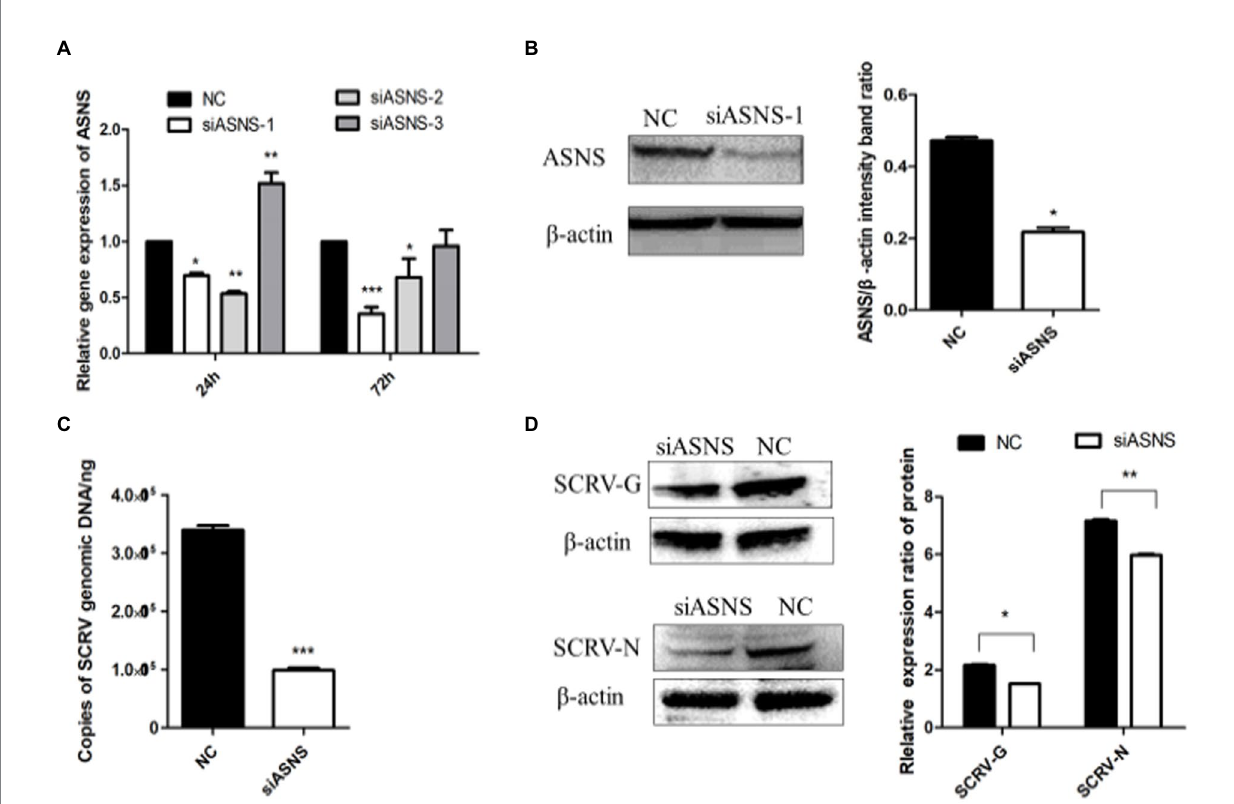
FIGURE 5 ASNS knockdown impaired SCRV replication. (A) The expression of ASNS mRNA in CPB cells treated with si-ASNS was detected. CPB cells fed with glutamine-containing medium were transfected with the three siRNAs and negative control (NC), and the cells were harvested at 24 and 72 h, respectively, and the transcript level of ASNS was detected by qPCR. (B) Validation of siRNA. The protein in the cells was harvested 72 h after siASNS-1 transfection, and western blot was used to verify whether siASNS-1 effectively knocked down the protein expression of ASNS. (C) The yield of SCRV when ASNS is knocked down. The cells were infected with SCRV (MOI = 1.O) 24 h after siASNS-1 transfection. The cells were collected at 72 hpi and the virus production was measured by qPCR. (D) Expression of SCRV-G/N protein in CPB cells after ASNS knockdown. Cells were infected with SCRV (MOI = 1.O) 24 h after siASNS-1 transfection. The protein in the cells was collected at 72 hpi, and the protein expression was detected by western blot. *